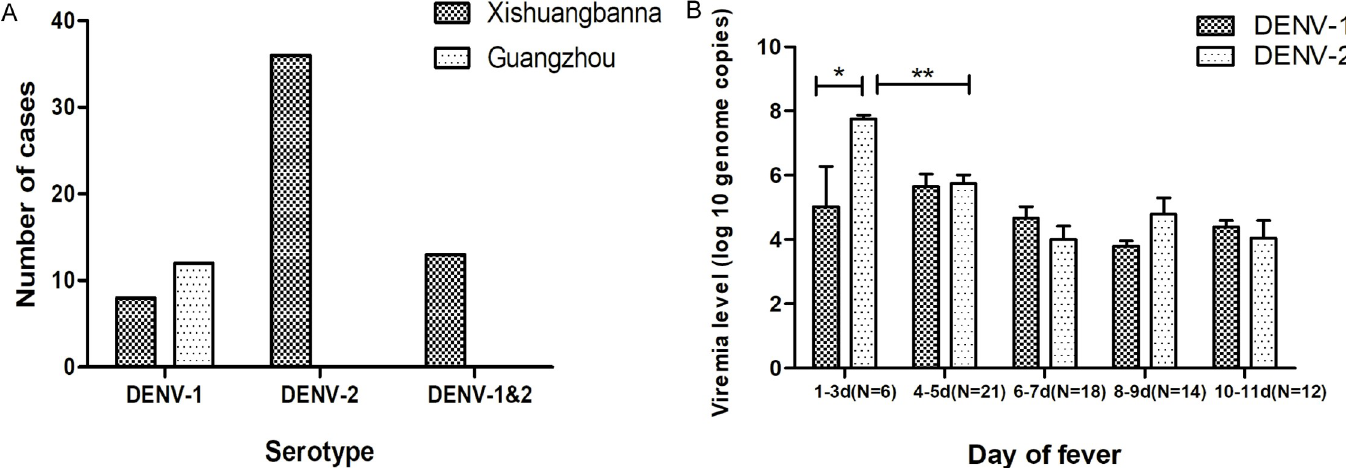
Fig 2. Serotyping and quantitating of DENV in the two study areas. (A) A comparison of the serotypes by RT-qPCR in the two study regions and (B) titering according to the onset day of fever in patients from which DENV RNA was isolated.